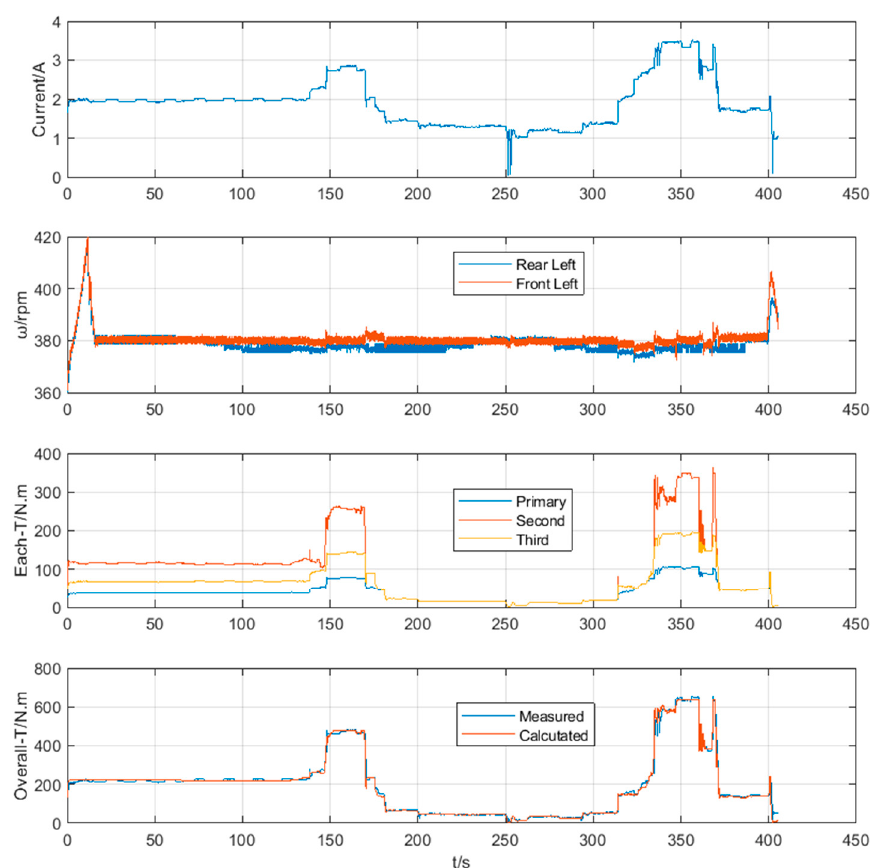
Figure 17. Real-car experiment in condition of locked